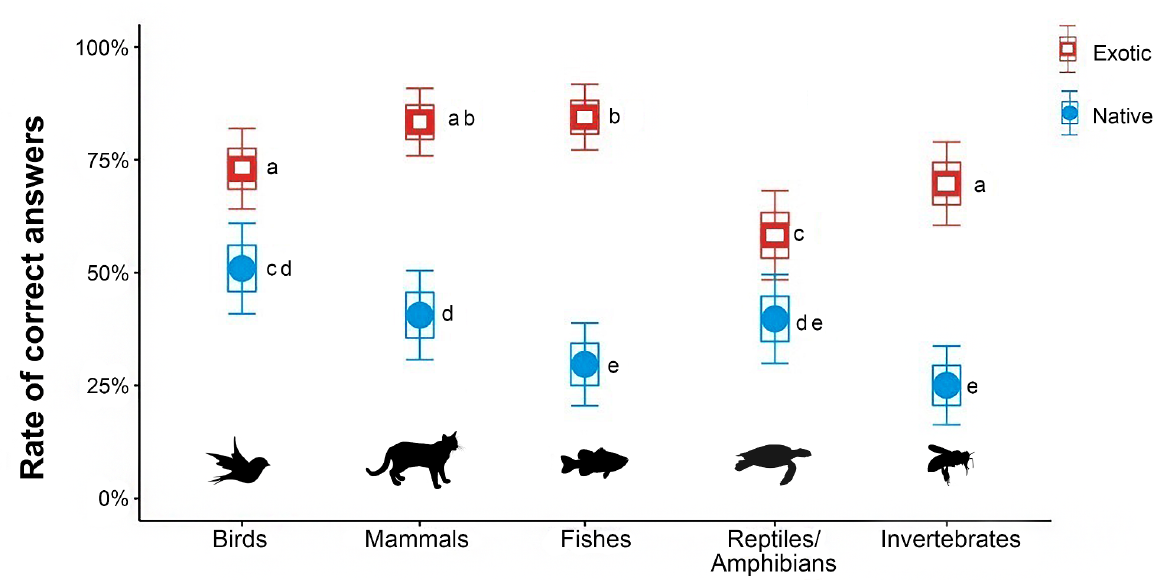
Figure 3. Mean correct identification rate by the students, between exotic and native Brazilian species, among the five zoological groups we considered in the study. The central point corresponds to the means, the boxes correspond to the standard error and the bars correspond to the 95% confidence intervals. Different letters indicate statistical differences among the means, at a 5%